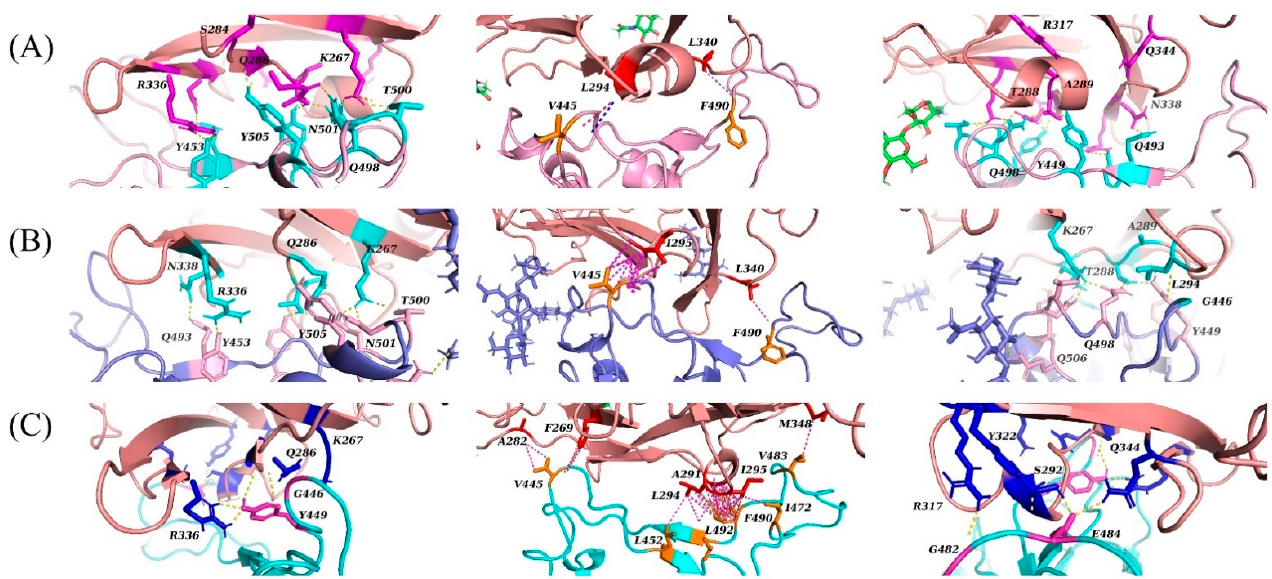
Figure 4. Predicted interactions between the RBD of SARS-CoV-2 and DPP4 obtained using flexible molecular docking with HADDOCK. In all panels, the interacting residues of DPP4 (salmon) and SARS-CoV-2 (pink, purple, cyan) are highlighted. ( A ) Docking variation CS1, ( B ) docking variation CS2 and ( C ) docking variation CS3.